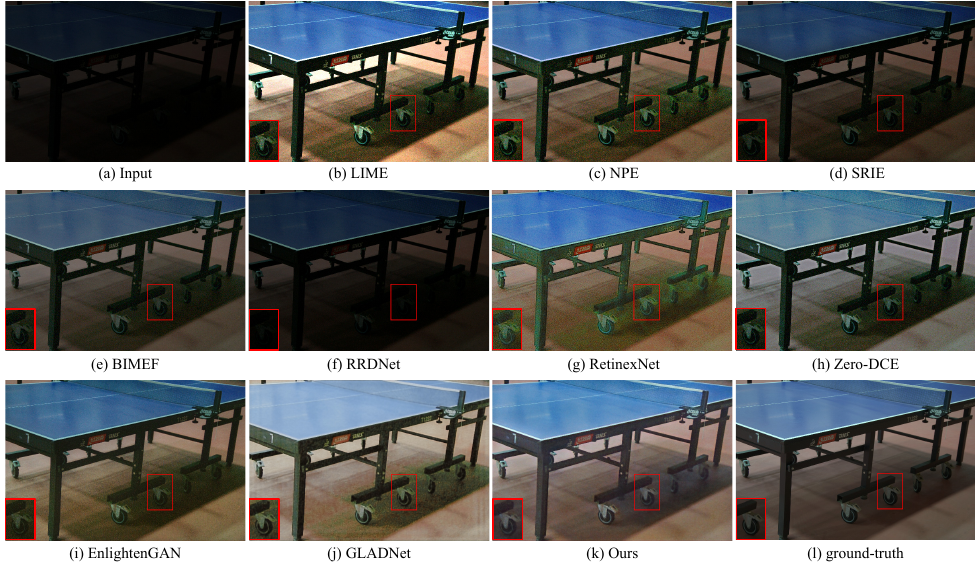
Figure 6. Visual comparisons of different methods on a real image from LOL dataset.